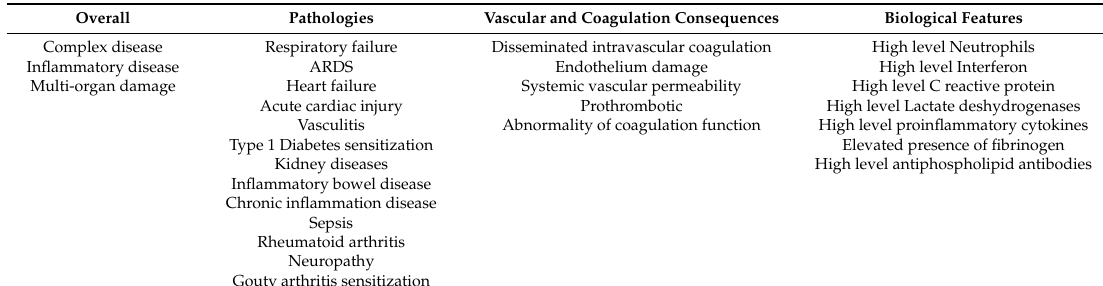
Table 2. Common pathological conditions or biological features shared by NETosis / extracellular DNA dysregulation and COVID-19 in severe